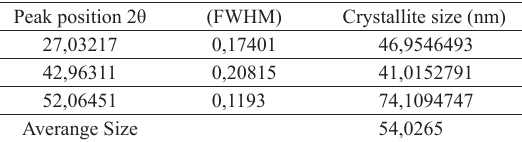
Table 1. Average size of CdS cristals on FTO substrate per CBD.